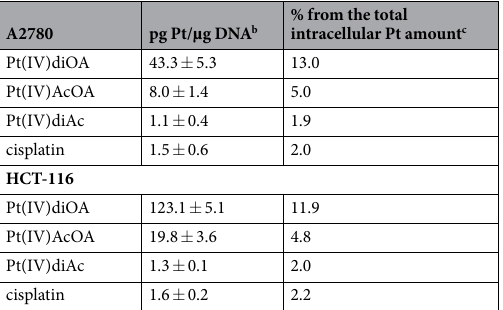
(Table 3). The platinum content of DNA from the A2780 cells treated with Pt(IV)AcOA and Pt(IV)diOA was approximately 7.3 and 39.4-fold greater, respectively than that of the cells treated with Pt(IV)diAc; or approxi- mately 5.3- and 28.9-fold greater, respectively, than that of the cells treated with cisplatin. Similarly, the platinum content of DNA from the HCT-116 cells treated with Pt(IV)AcOA and Pt(IV)diOA was approximately 15.2 and 94.7-fold greater, respectively than that of the cells treated with Pt(IV)diAc; or approximately 12.4- and 76.9-fold greater, respectively, than that of the cells treated with cisplatin. We made a rough estimate of the percentage of the amount of platinum in the DNA fraction of the total amount of intracellular platinum considering data in Tables 2 and 3. Of the total intracellular Pt, a higher fraction of platinum from Pt(IV)AcOA or Pt(IV)diOA was bound to DNA in comparison with the treatment with Pt(IV) diAc or cisplatin (Table 3). In aggregate, the presence OA axial ligands in the Pt(IV) derivatives of cisplatin mark-